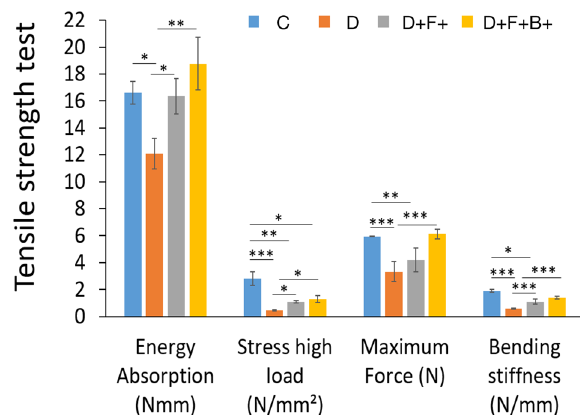
Figure 10. Tensiometery analysis of wound tissue at different time points post-injury. Mean ± SD of the energy absorption, wound strength, bending stiffness, maximum force and stress high load at 28 post-injury in the wound healing site in the study groups as compared by the ANOVA and LSD; (*P < 0.05, **P < 0.01 and ***P < 0.001). One-way ANOVA, analysis of variance and LSD, least significant difference; C; D; D + F + B; D + F + B +